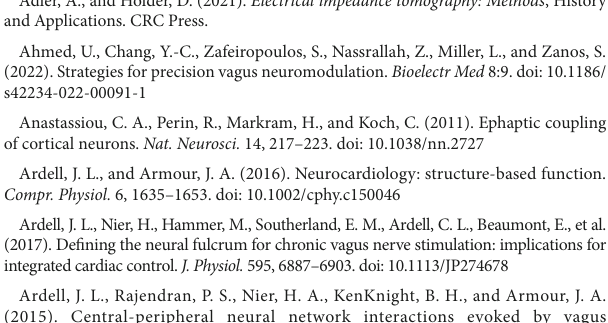
SUPPLEMENTARY TABLE Morphology Data and Analyses of Porcine Vagus Nerve. SUPPLEMENTARY DATA SHEET Supplementary